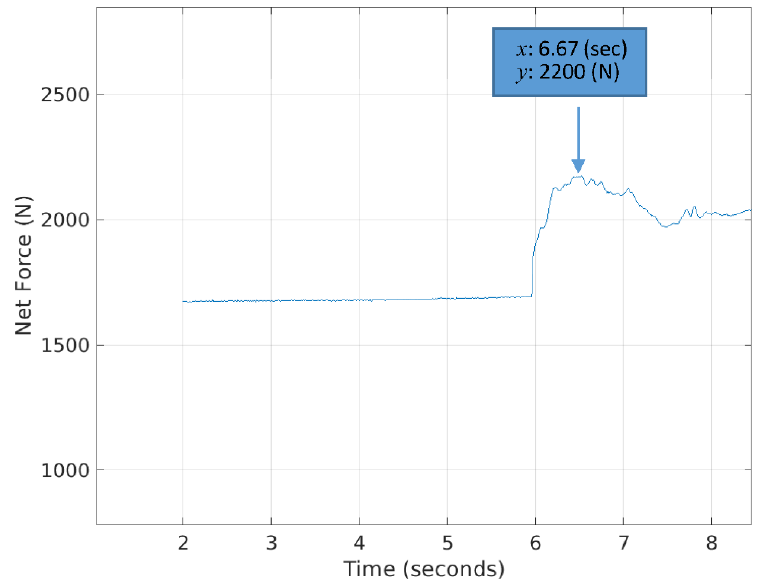
Figure 27. Variation of the bucket net force during the digging in the 6th segment (Natural Ground 3).